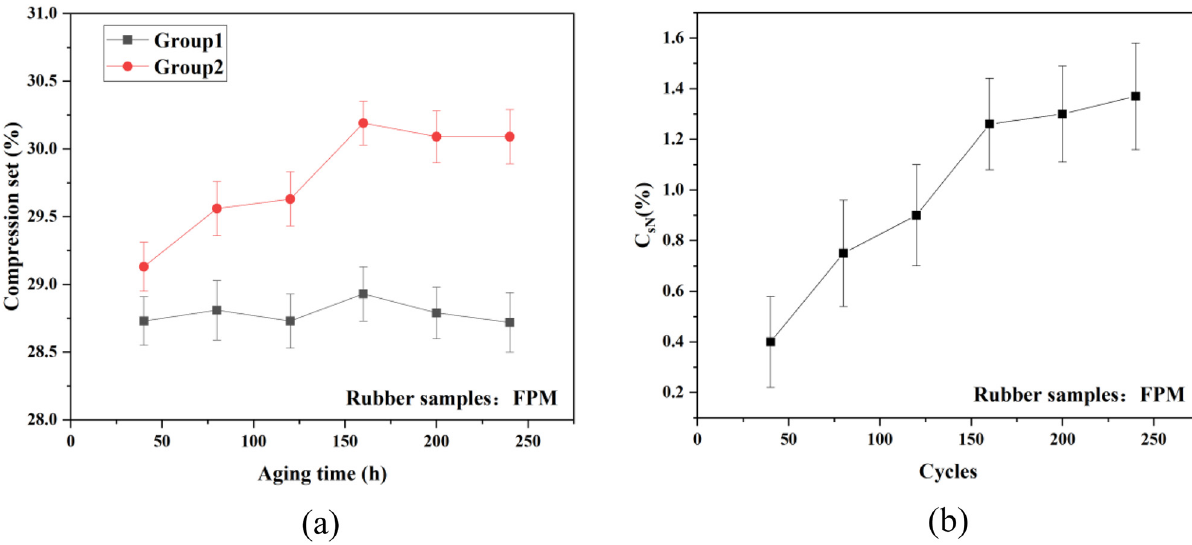
Figure 6: Compression set test results of FPM under ( a ) di ff erent environmental aging and ( b ) di ff erent cycle number N conditions.